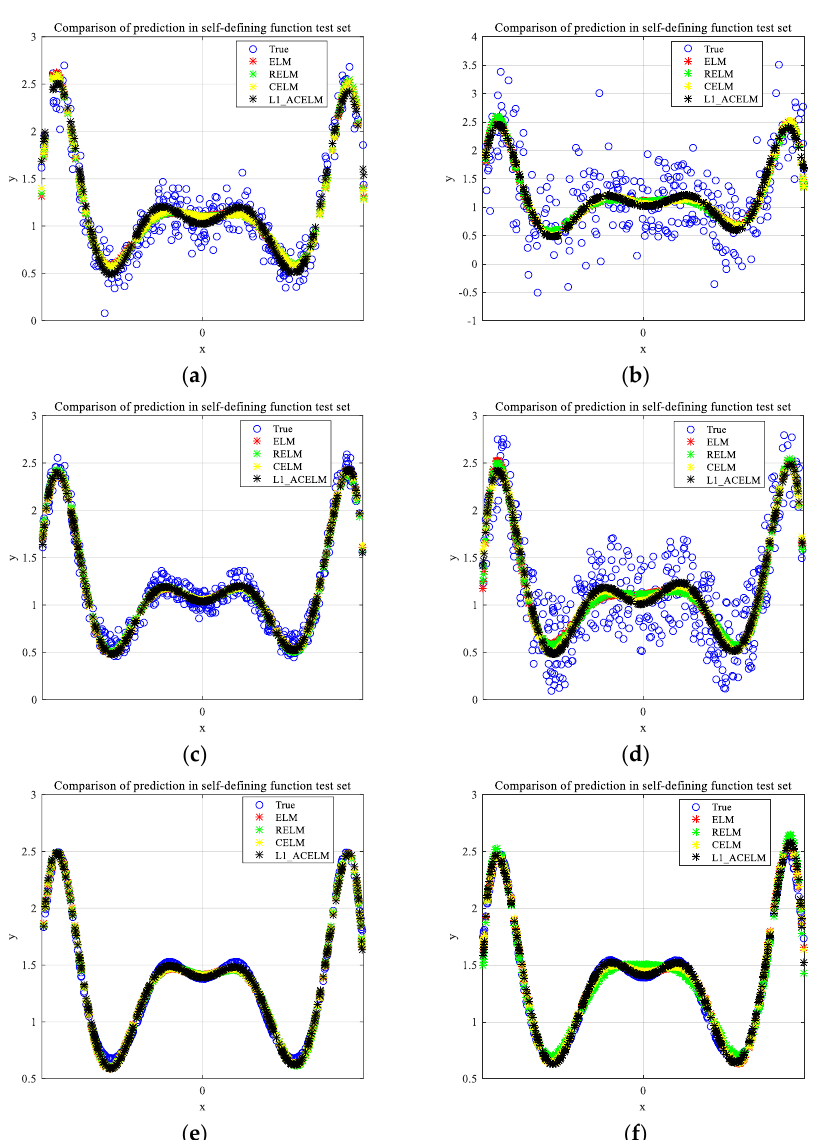
Figure 5. Fitting results of the self-defining function with different noises. Table 2. Experiment results on artificial datasets with different types of noise.